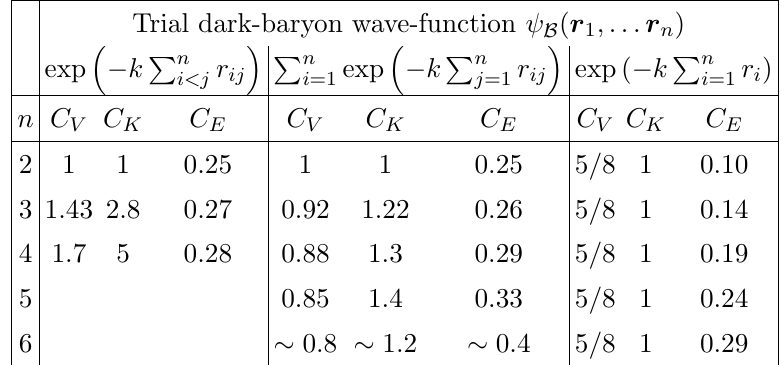
Table 2 . Binding energies of anti-symmetric bound states made of n dark-quarks with mass m with a non-abelian Coulombian potential. We use the variational method and assume three di(cid:11)erent trial wave functions. The coe(cid:14)cients C V;K;E are de(cid:12)ned in eq. (3.8). In particular, for n = N DC the bound states are dark baryons, and E B = C E ( C N (cid:11)